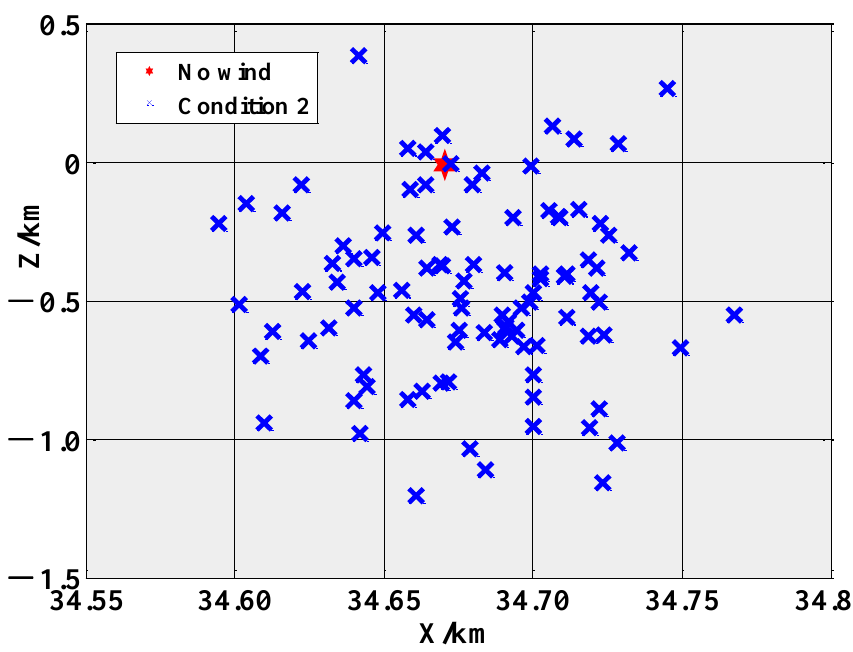
Figure 14. Impact dispersion of the rocket projectile under the influence of condition 2 (simulation time = 100).